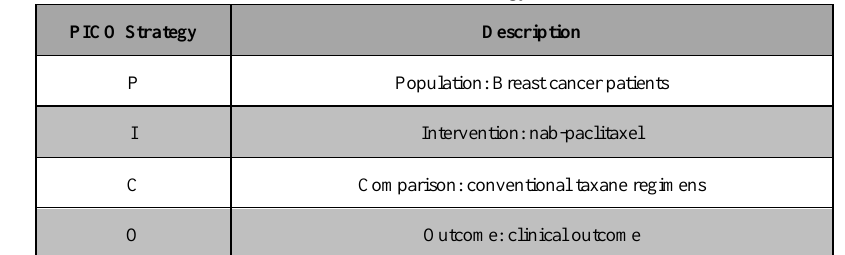
Table1. PICO strategy.